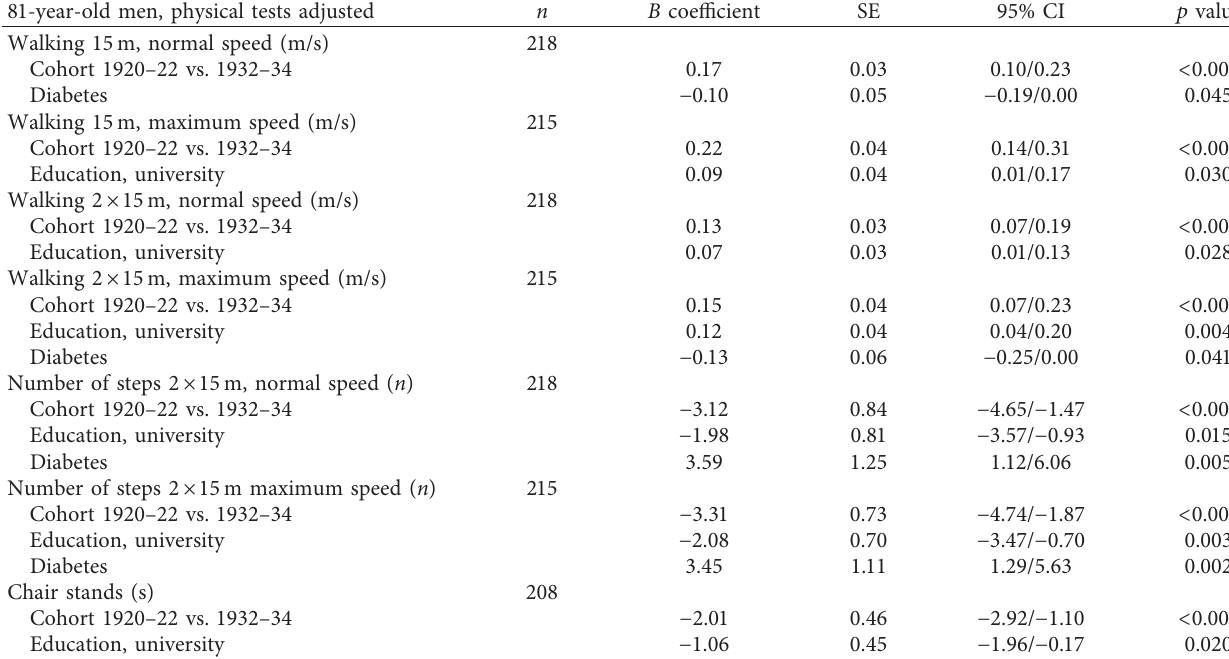
Table 4: Adjusted linear regression models for 81-year-old men with the results of the physical tests as the dependent variables and birth cohort as the independent